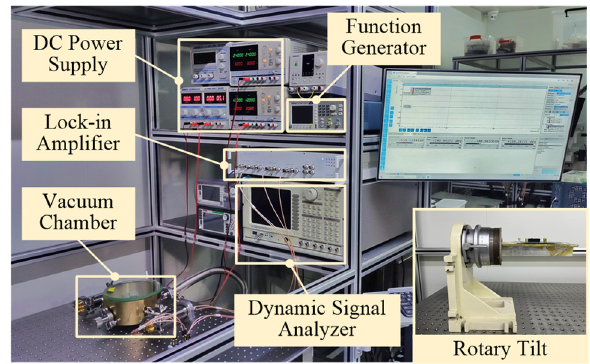
Figure 7. Experiment platform and apparatus.